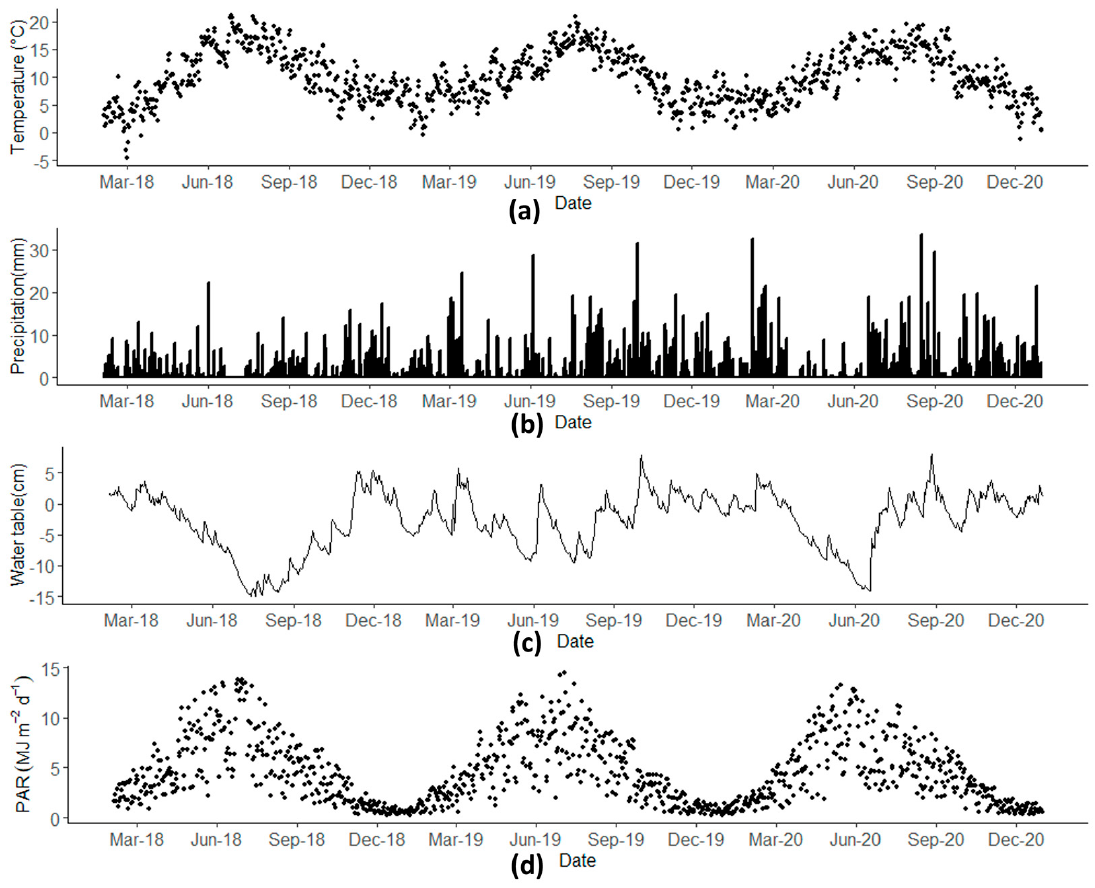
Figure 4. The seasonal temporal dynamics of meteorological parameters: ( a ) Average air temperature ( ◦ C), ( b ) Total daily precipitation (mm), ( c ) Water table depth (cm), and ( d ) Total daily PAR (MJ m − 2 d − 1 ).